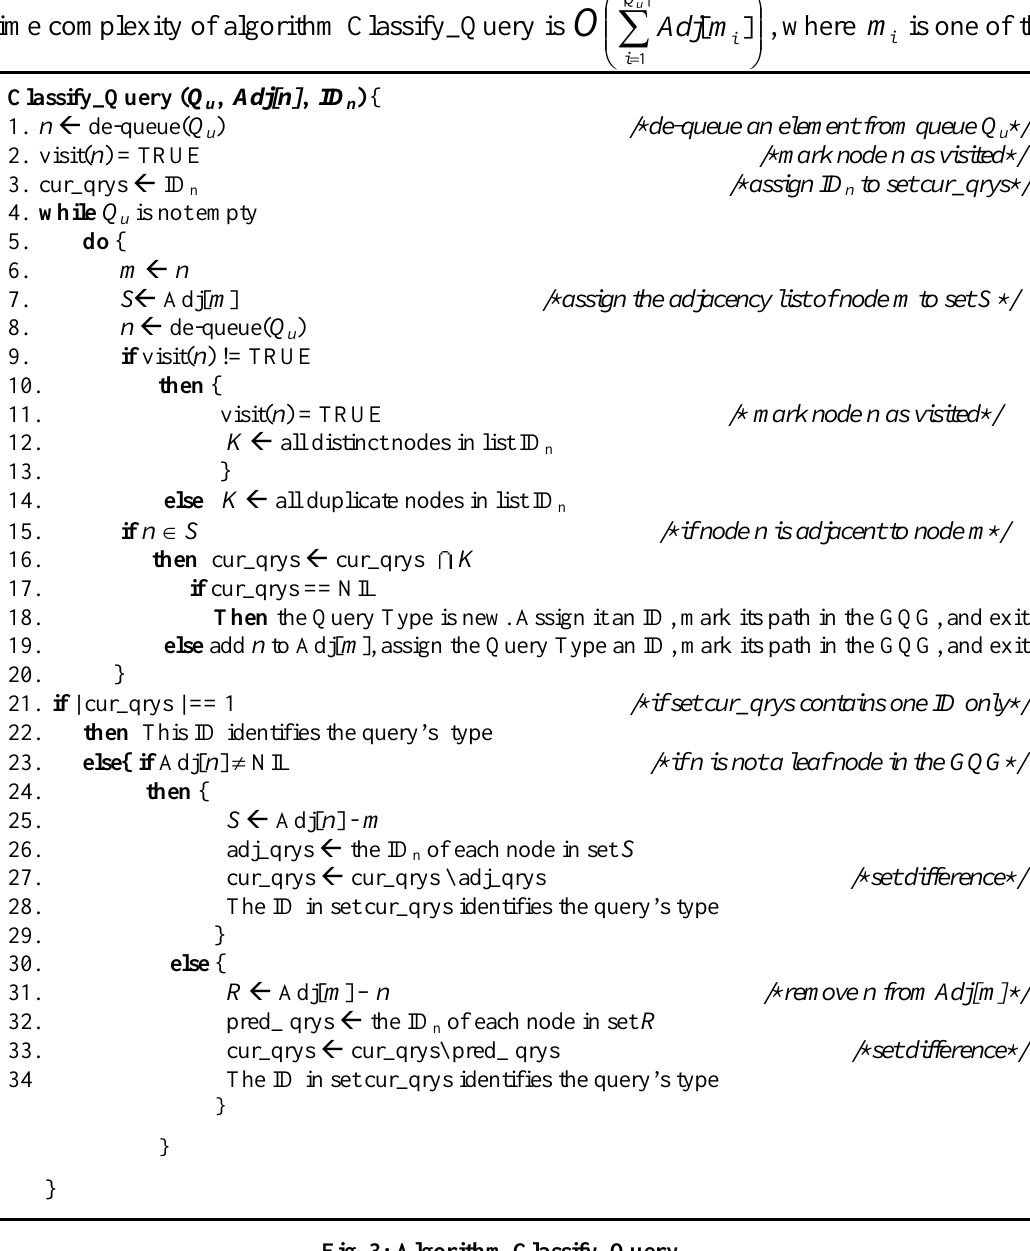
Fig. 3: Algorithm Classify_Query